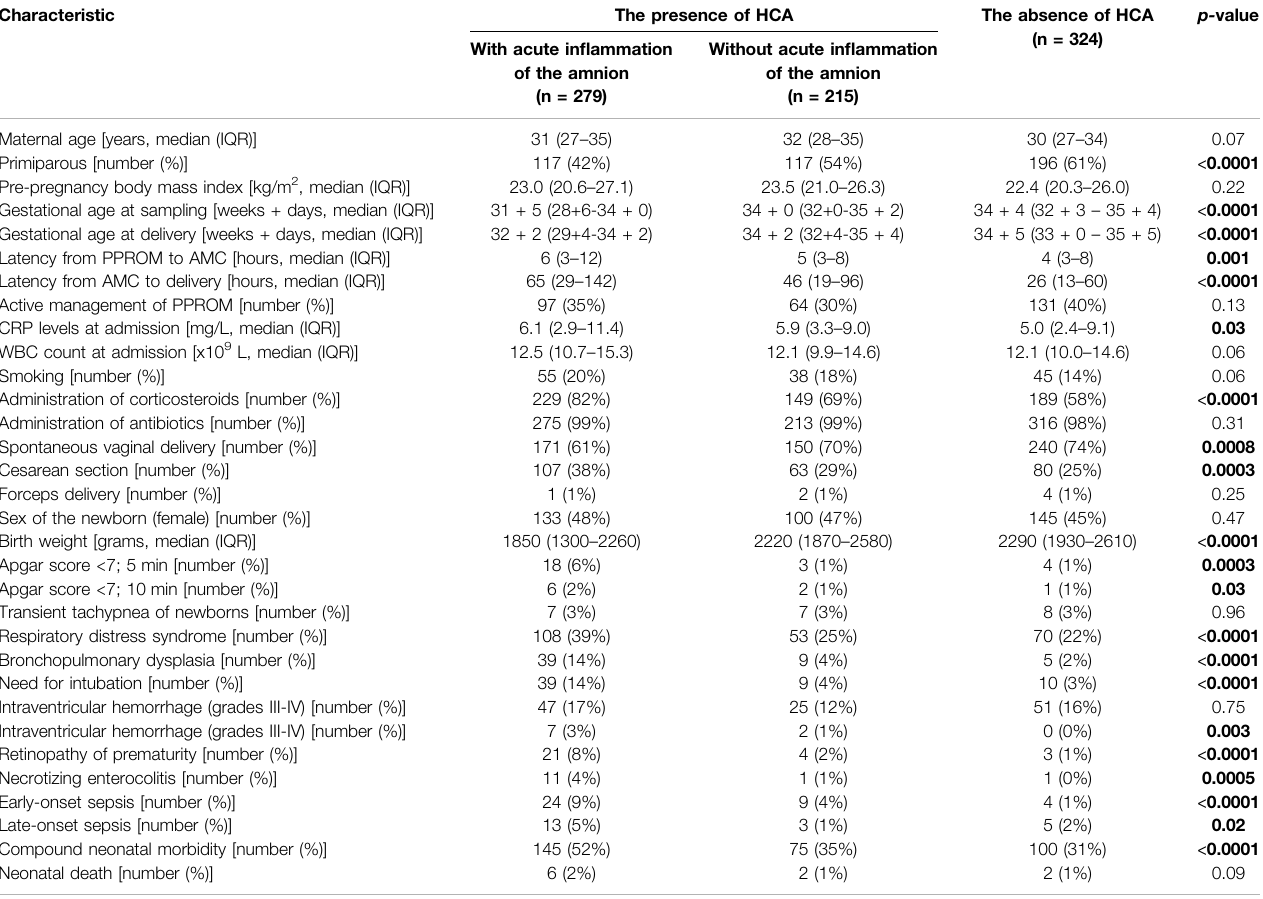
p- value (n = 324) With acute in fl ammation Without acute in fl ammation of the amnion of the amnion (n = 279) (n = 215)